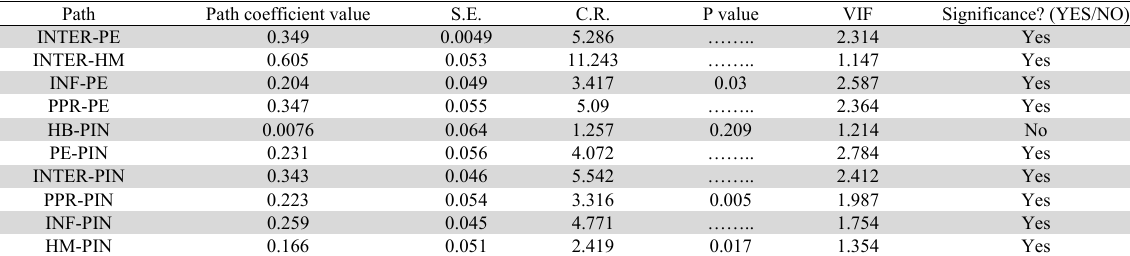
Results of Standardized Estimates of the Structured Model